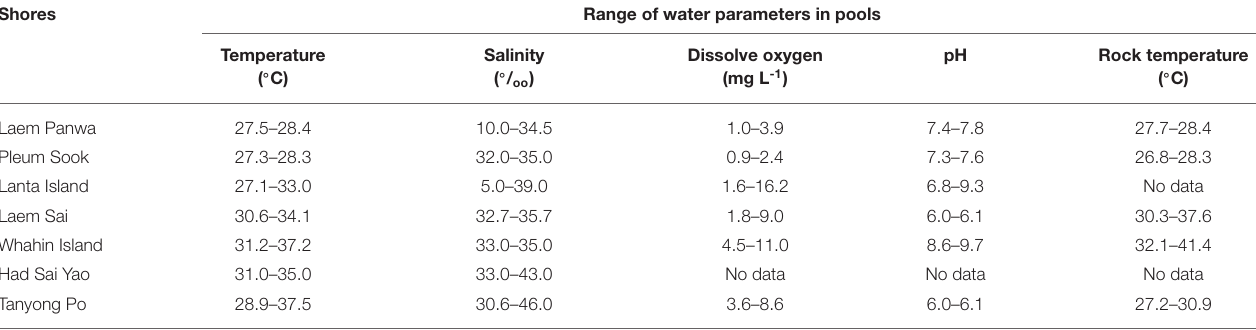
TABLE 1 | Range of variations in the physico-chemical environment of rock pools. Shores Range of water parameters in pools